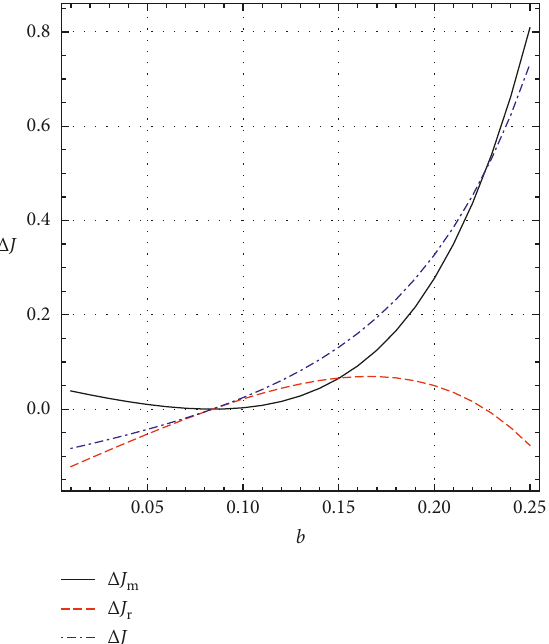
Figure 4: Comparison of steady-state profits with b .